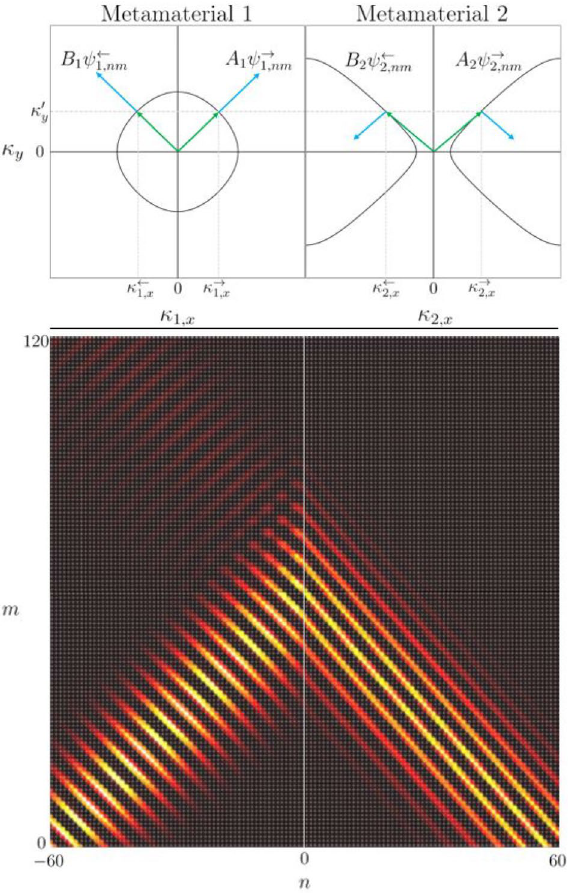
1 / l for a scattering matrix with = 60 with tilt given by κ 1 / l ′ y = = −